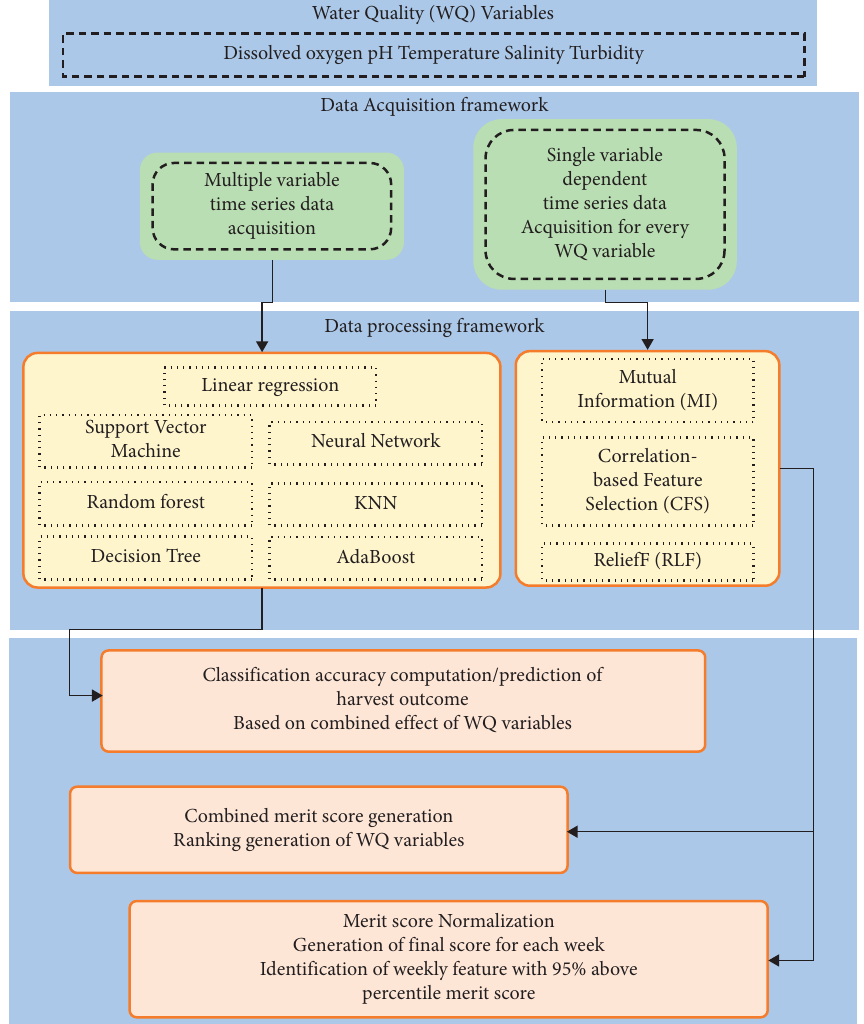
Figure 2: Schematic diagram of the proposed framework for pond classifcation, water quality ranking, and water quality parameter efect on prawn yield and